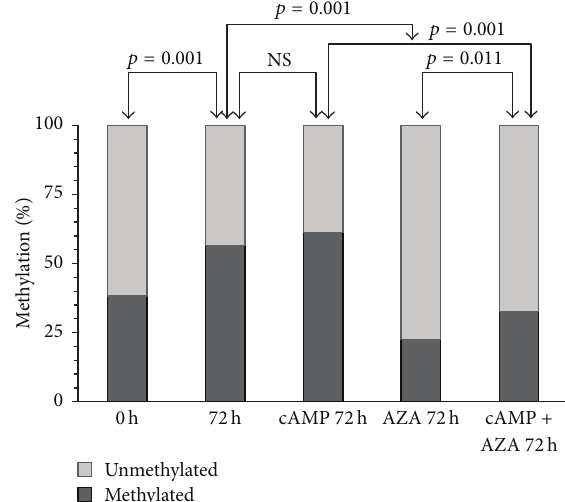
Figure 2: Methylation of the CRH promoter. Percent methylation of the9 CpGsitestogetherwascalculatedbycombiningthreeindepen- dent experiments and ten randomly selected clones (individual gene copies) sequenced per treatment in each experiment. Methylation frequencies were compared by Fisher’s exact test. Statistical com- parisons ( 𝑝 < 0.05 , significant and NS, not significant) are shown by the arrows. 0h, no treatment; 72 h, 72 h of culture; cAMP 72 h, treatment with 2.5 × 10 −4 molL −1 of 8-Br-cAMP for 72 h; AZA 72 h, treatment with 5 × 10 −6 mol L −1 5-AZA-dC for 72 h; cAMP + AZA 72 h, combined treatment with 8-Br-cAMP and 5-AZA-dC for 72